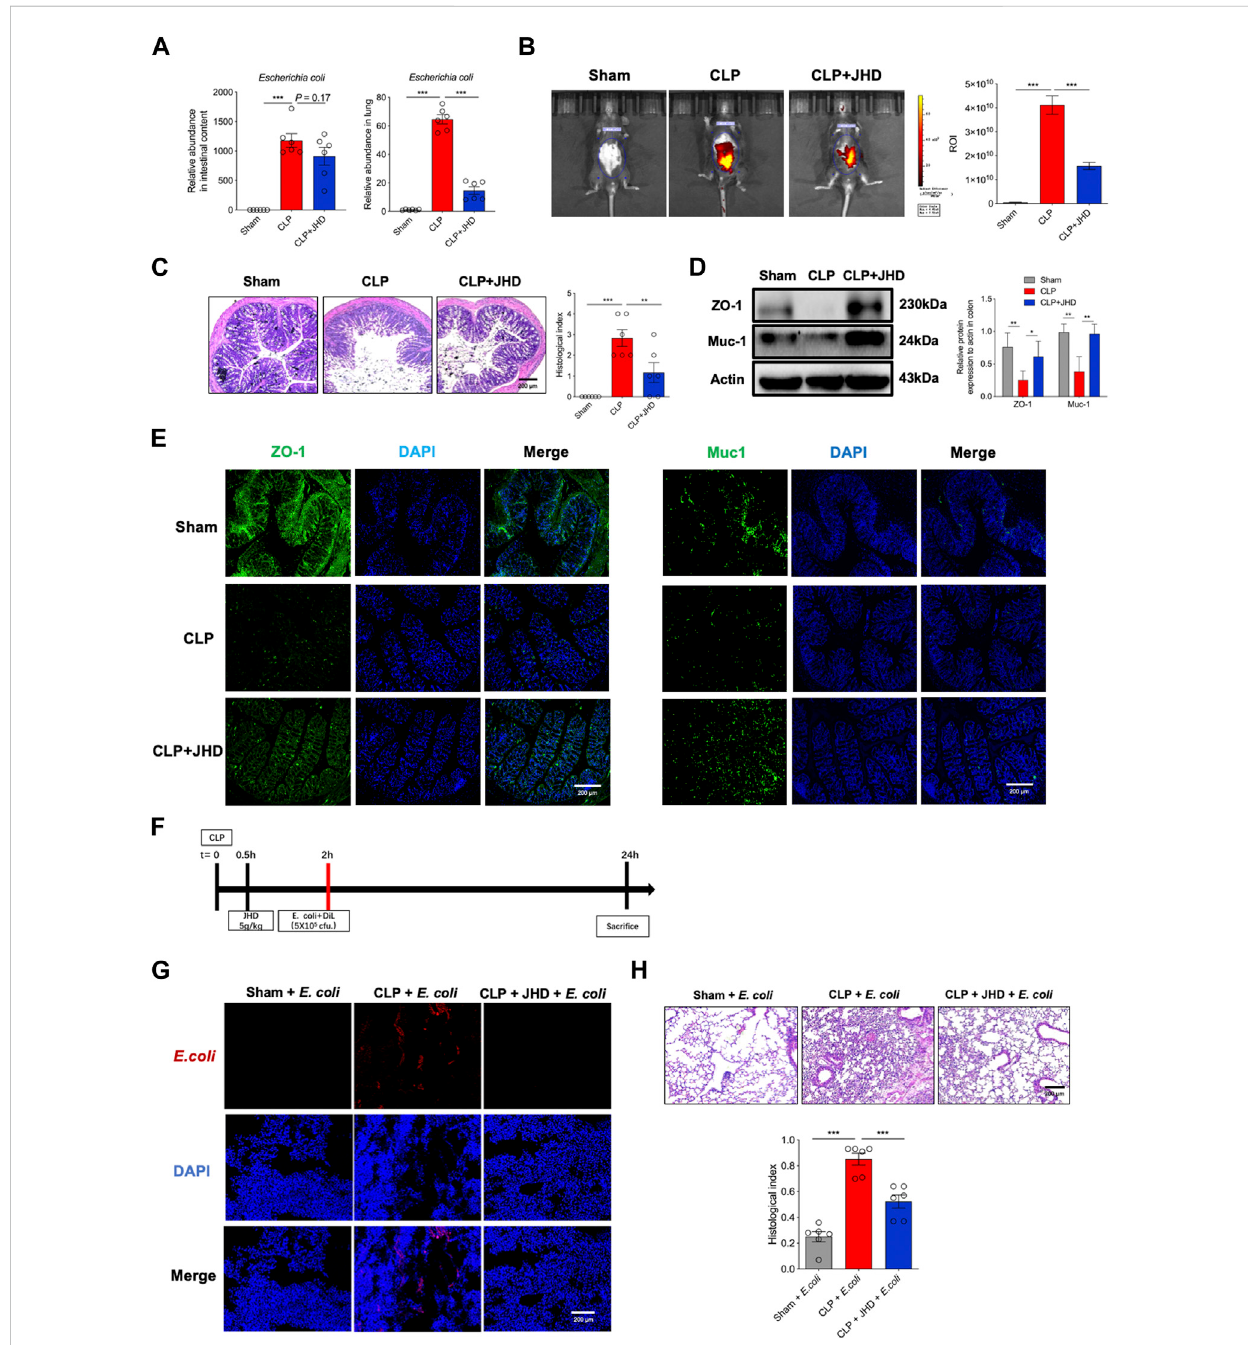
FIGURE 6 JHDimprovesintestinalmucosalbarrierandpreventsgutbacterialtranslocationforinductinglungin fl ammation. (A) Relativeabundanceof E.coli in intestinal contents and lung tissues; (B) Intestinal barrier permeability measured by in vivo imaging of FITC-dextran; (C) H&E staining of colon tissues and correlatedhistologicalanalysis(magni fi cation:×400,scalebar=200 μ m);ZO-1andMuc-1incolontissuesweredeterminedby (D) Westernblottingand (E) immuno fl uorescence; (F) Experimental fl ow chart; (G) DiL-labeled E. coli in frozen lung sections; (H) H&E staining of lung and correlated pathological scores (magni fi cation: ×400, scale bar = 200 μ m) (mean ± SD, n = 6;* p < 0.05, ** p < 0.01, *** p <